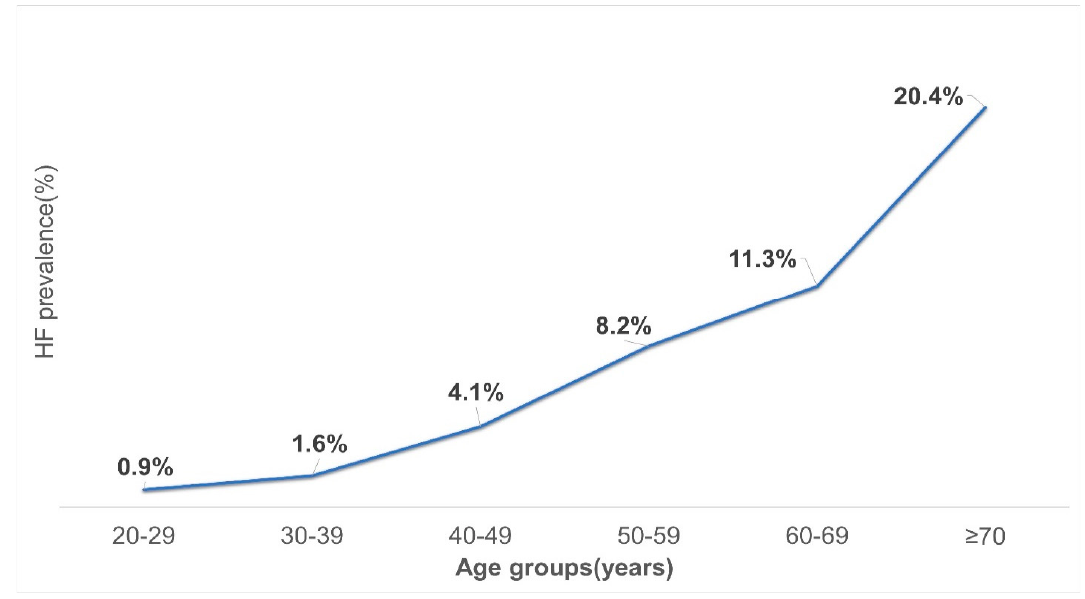
Figure 2. Age–specific prevalence of HF. Note: The vertical axis shows prevalence rate expressed as a percentage. The horizontal axis shows age groups.